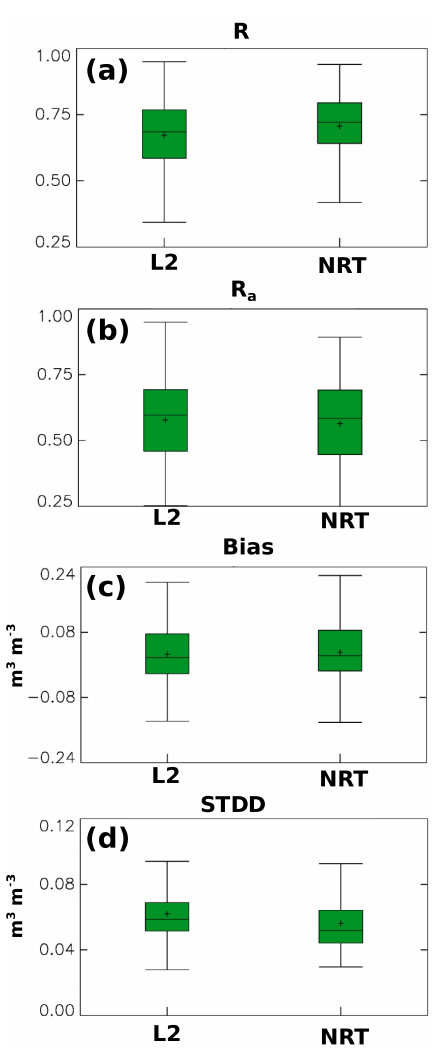
Figure 5. Box plots for (a) the Pearson correlation coefficient ( R ) of the NRT and L2 time series with respect to the in situ measure- ments, (b) Pearson correlation coefficient of the anomalous time series ( R a ), (c) bias (mean in situ minus mean SMOS SM) and (d) STDD of the two SMOS products in comparison to in situ mea- surements. The green boxes contains the middle 50% of the data, the central bar represents the median value of the distribution. The upper edge (hinge) of the box indicates the 75th percentile of the dataset ( q 3 ), and the lower hinge indicates the 25th percentile ( q 1 ). The mean values are also shown as black crosses. The upper and lower bars represent the minimum and maximum values of the dis- tribution excluding outliers. Points are considered as outliers if they are larger than q 3 + 1.5( q 3 − q 1 ) or smaller than q 1 − 1.5( q 3 − q 1 ).